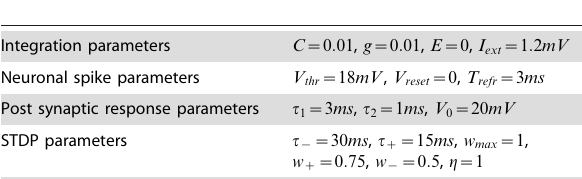
Table 1. Default parameter values of the spiking neuron